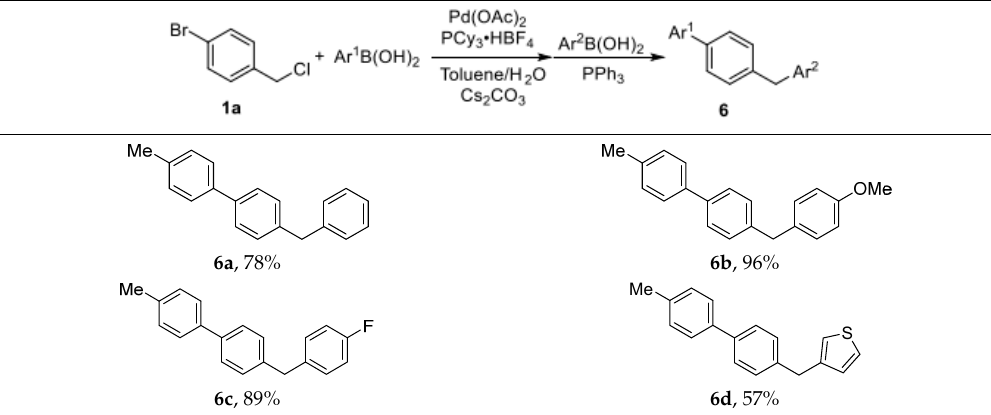
Molecules 2018 , 22 , 433 Table 5. One-pot dual arylations of 1-bromo-4-(chloromethyl)benzene a. Table 5. One-pot dual arylations of 1-bromo-4-(chloromethyl)benzene a. Table 5. One-pot dual arylations of 1-bromo-4-(chloromethyl)benzene Table 5. One-pot dual arylations of 1-bromo-4-(chloromethyl)benzene a. Table 5. One-pot dual arylations of 1-bromo-4-(chloromethyl)benzene a. Table 5. One-pot dual arylations of 1-bromo-4-(chloromethyl)benzene a. Table 5. One-pot dual arylations of 1-bromo-4-(chloromethyl)benzene a. Table 5. One-pot dual arylations of 1-bromo-4-(chloromethyl)benzene a.